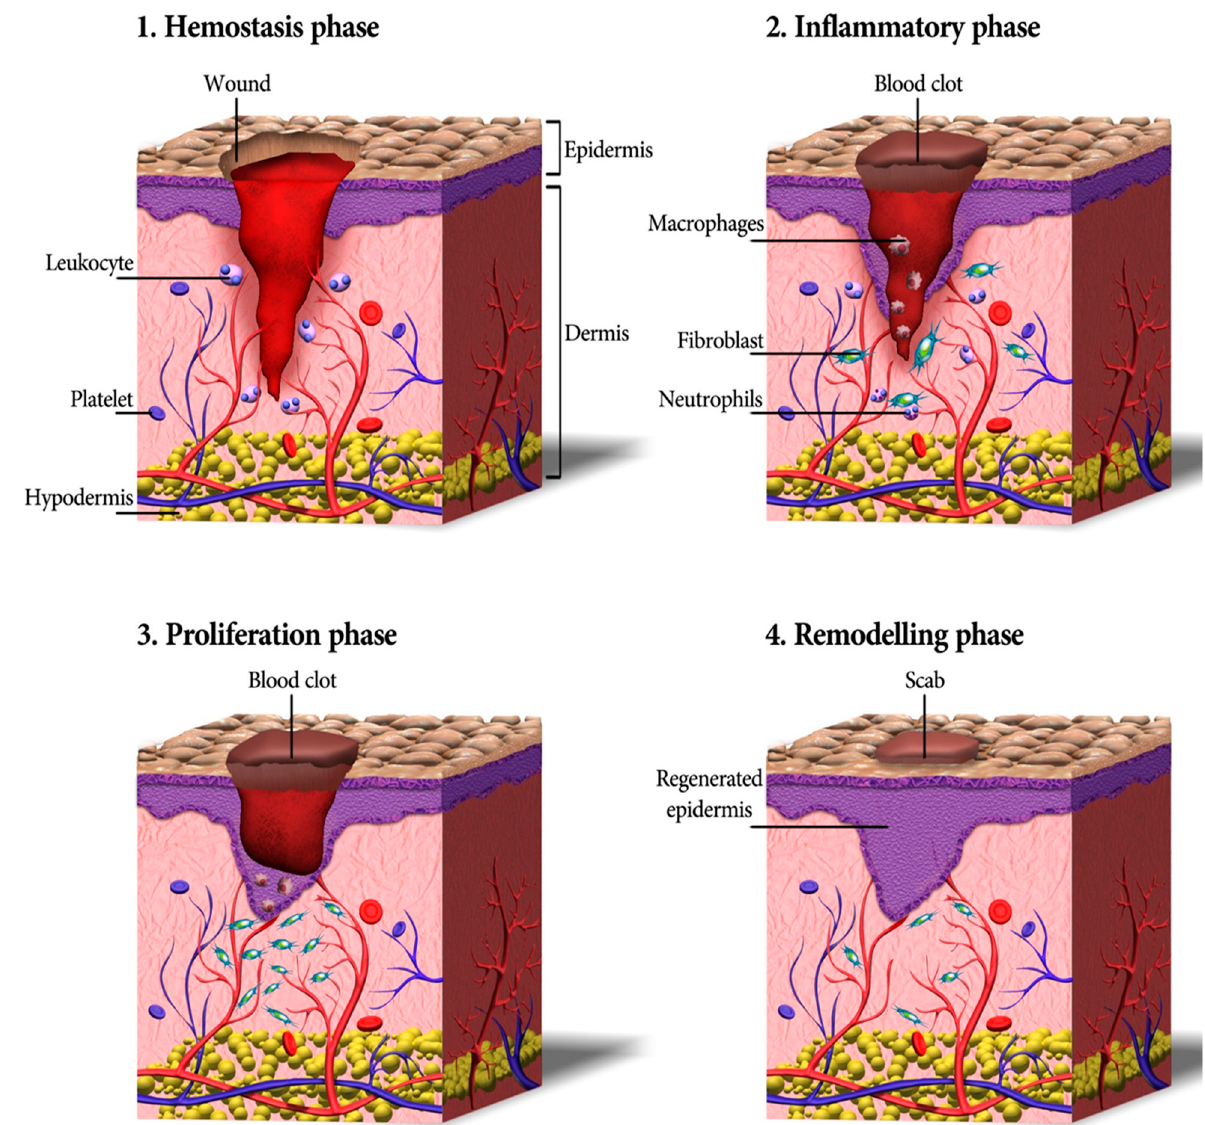
Figure 1. A schematic depicting the process of wound healing, including four continuous phases— homeostasis, inflammation, proliferation, and remodeling. Firstly, blood platelets are activated to form a blood clot and have a role in leukocyte recruitment. Next, neutrophils and macrophages clean the wound site from dead cells, bacteria, and other pathogens or debris. Then, fibroblasts migrate, proliferate, and activate the angiogenesis process. Finally, granulation tissue is formed, the deposition of extracellular matrix proteins occurs to reconstitute the dermal tissue, and the epidermis is regenerated. Eventually, many of the formed capillaries and fibroblasts disappear [17]. Hemostasis and Inflammation Phases Most skin injuries, even superficial wounds, caused bleeding. Blood loss and the risk of infection is reduced by the clotting mechanism in which fibrinogen produced in the exudate stimulates a fibrin clot formation and seals the wound site. Therefore, hemostasis provides a protective barrier and contributes to successful wound healing [32]. The